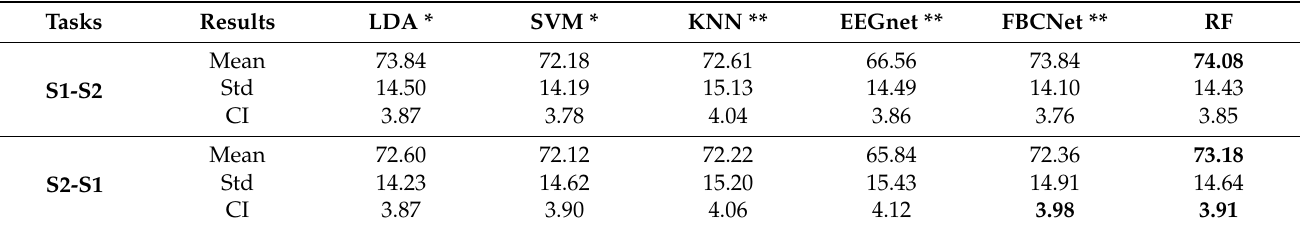
Table 4. A comparison of the different classifiers in the cross-session